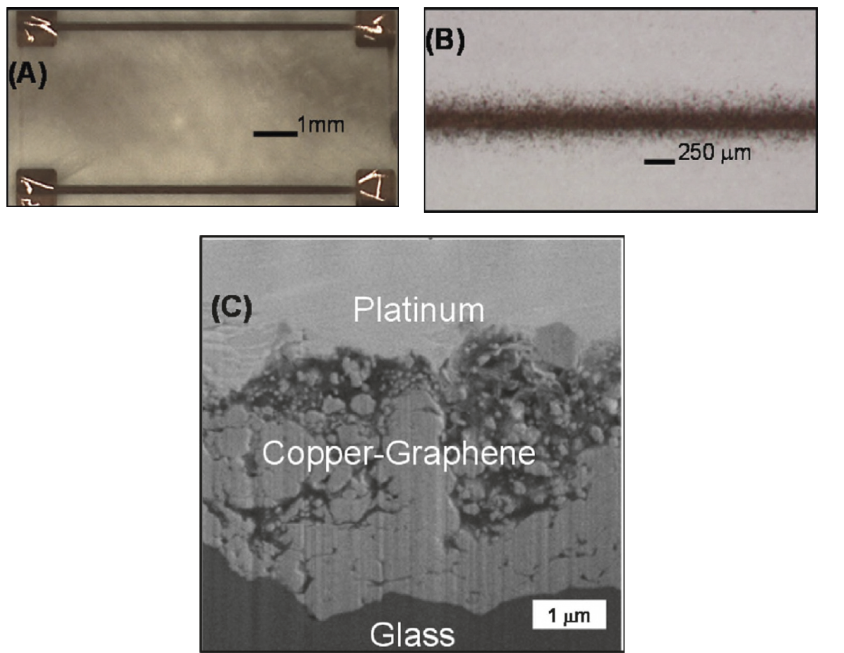
Figure 15: Characterization of graphene-Cu MMC coating produced using electroless-plated powders: (A) optical view of two tracks, (B) single-line track, and (C) coating cross-sectional view